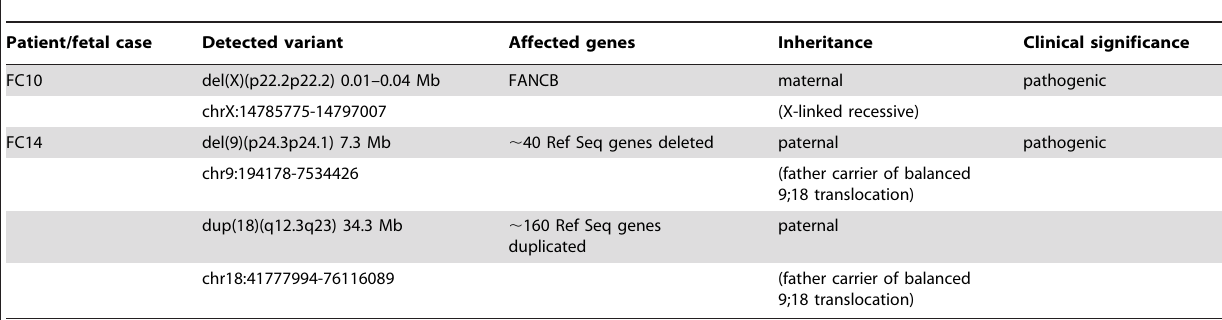
Table 2. Pathogenic gene dose imbalances identified using